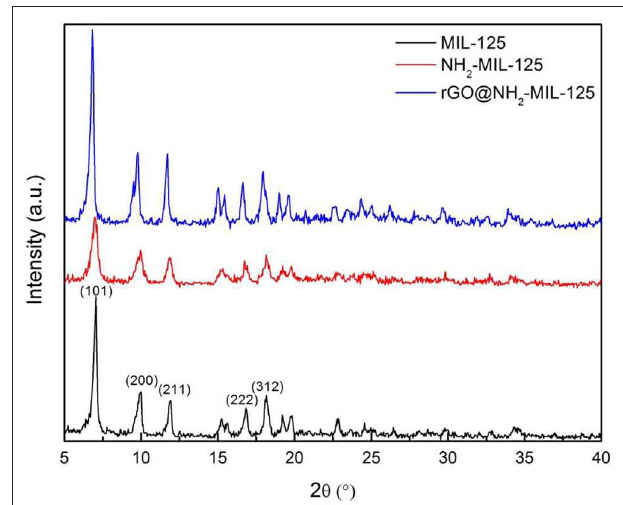
FIGURE 1 | The XRD patterns of the three acquired